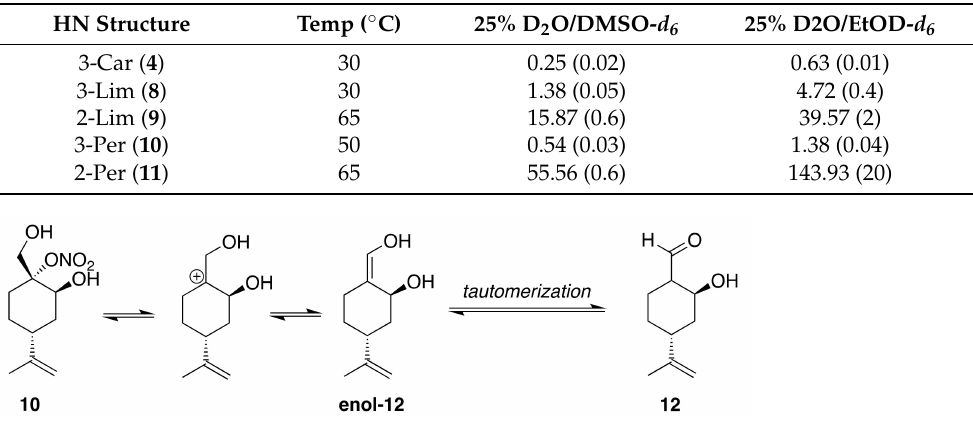
Figure 6. Proposed mechanism of aldehyde formation from 3-Per ( 10